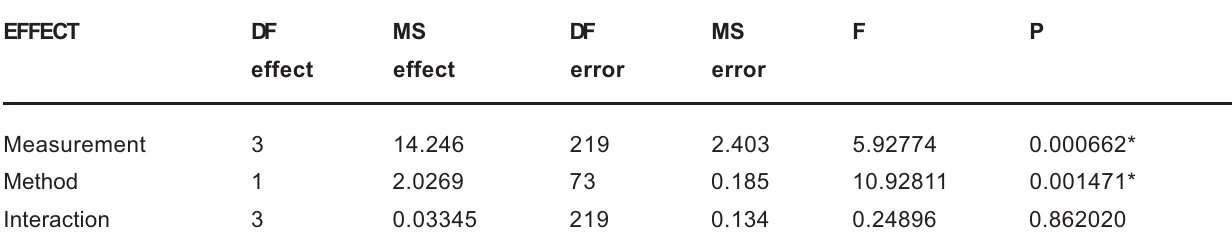
TABLE 2- Two-way analysis of variance (measurement and method) with repetition